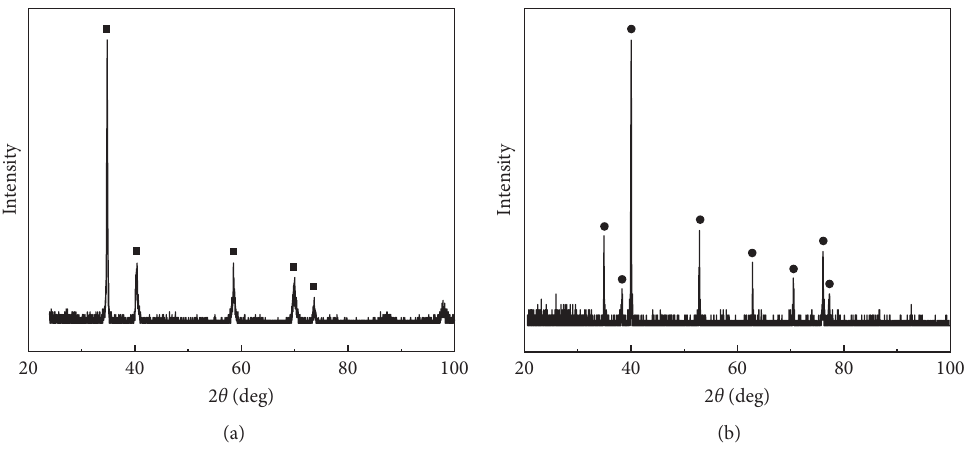
2 δ phase ( ■ ) and (b) Ti HDH α phase ( ● ).